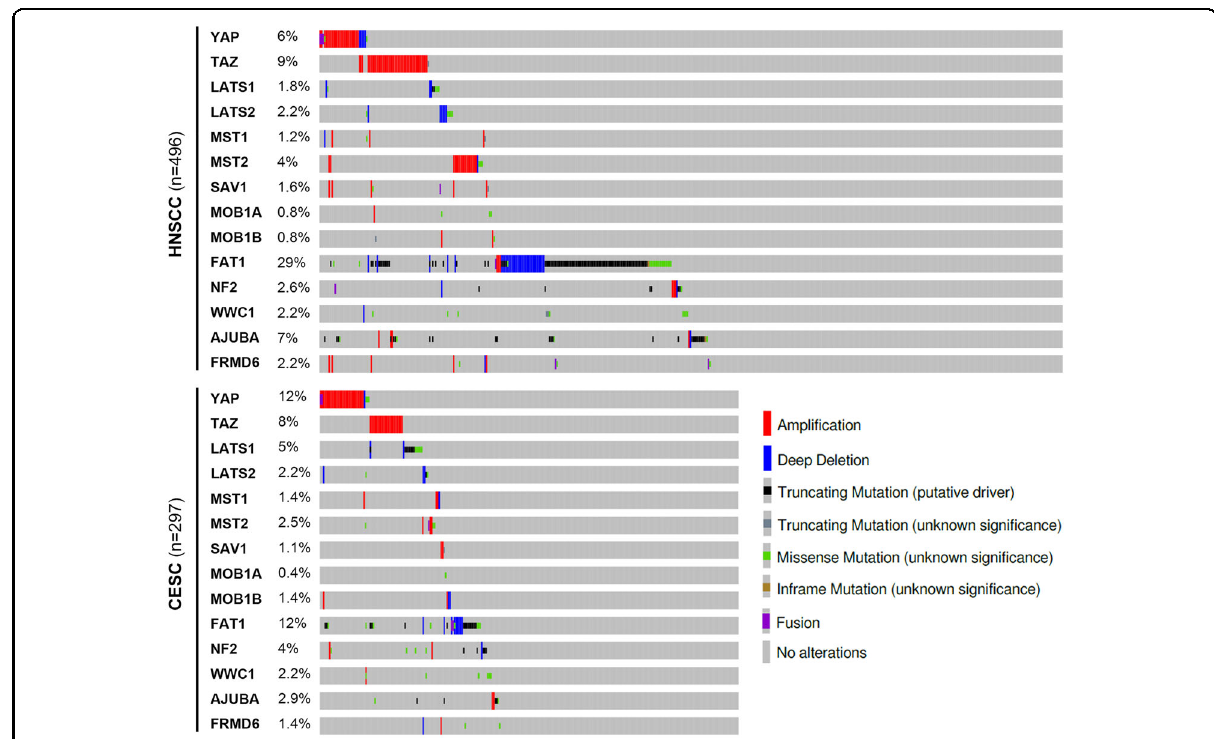
Fig. 4 Genetic alteration in Hippo-YAP pathway genes. The proportion of somatic alterations in Hippo pathway genes in HNSCC and CESC samples. TCGA PanCancer Atlas data were retrieved with